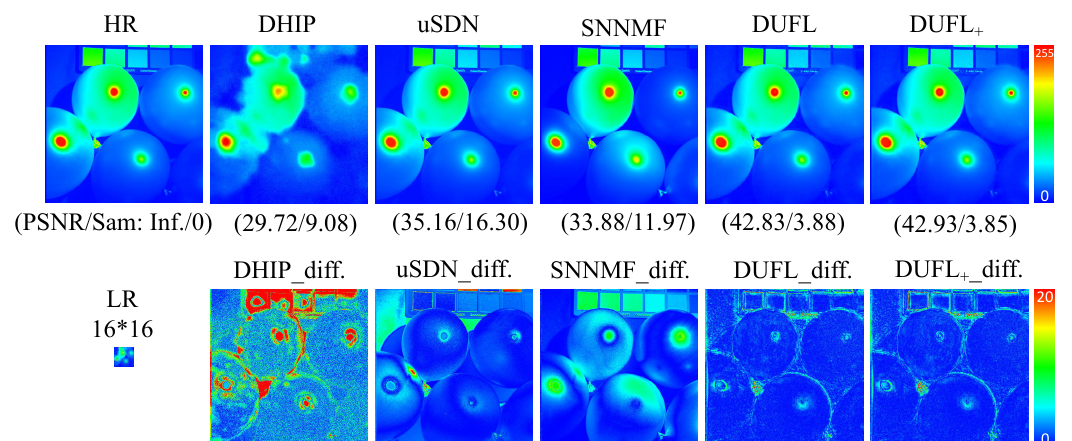
Figure 4. Recovered HR-HS image of the (cid:48) Balloon (cid:48) sample in the CAVE dataset using the DHIP [24], uSDN [41], SNNMF [51], and the proposed methods and corresponding difference images between the ground-truth and recovered images with an upscale factor of16.